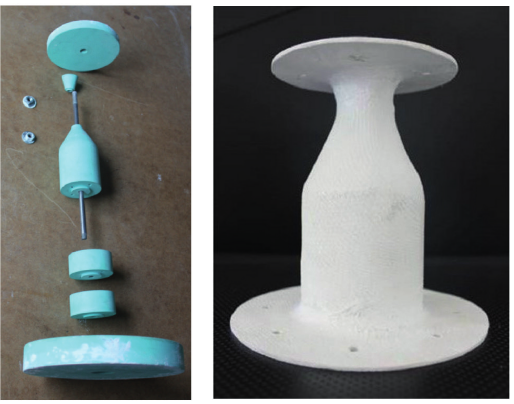
Figure 6. ( left ) Segmented structure of the production mould and ( right ) first manufactured prototype with a total mass of around 300g.